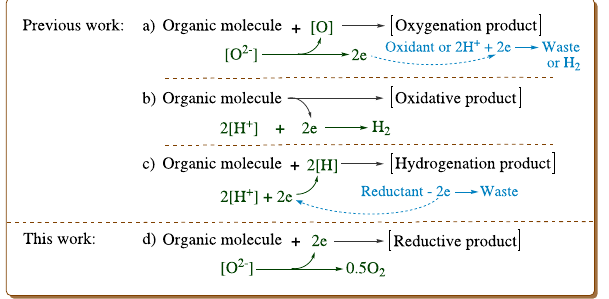
Fig.1|Backgroundofthiswork. OrganicreactionswithH 2 Oastheoxygensource ( a ), the oxidant ( b ), the hydrogen source ( c ) or the electron donor ( d ).